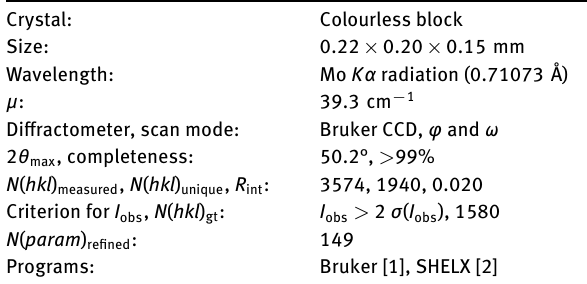
Table 1: Data collection and handling.